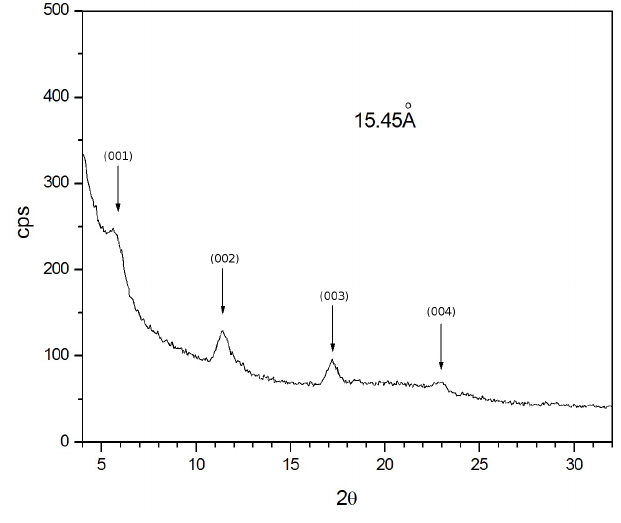
Figure 2. Grazing angle X-ray diffraction pattern of the 2010-017, 6 ML pentacene